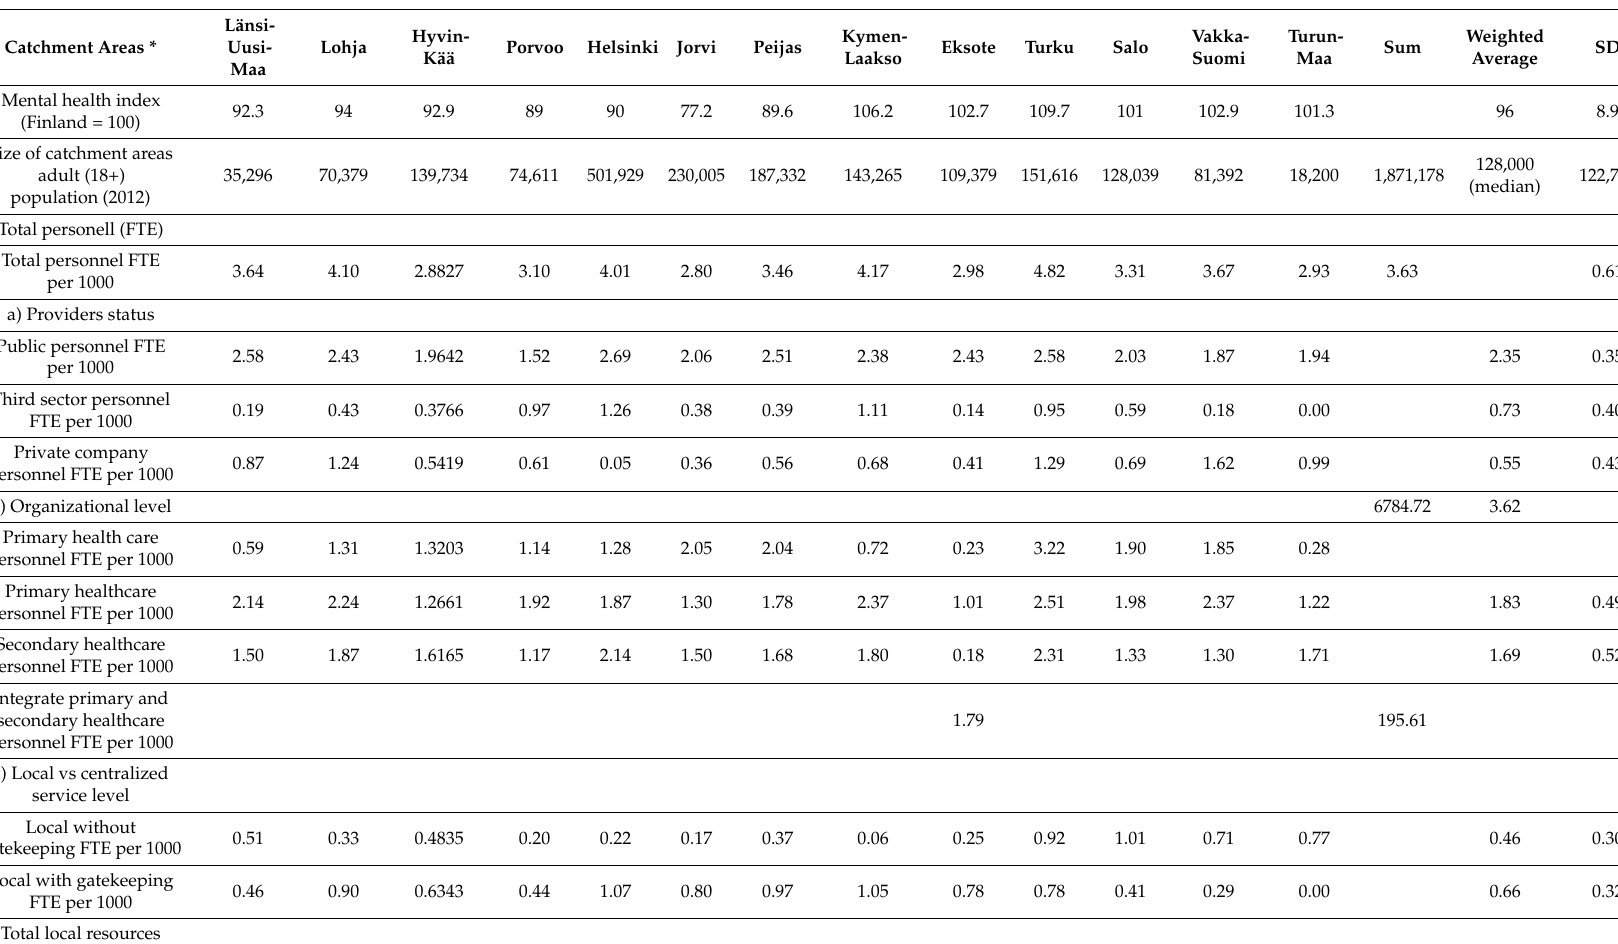
Kymen- Eksote Turku Salo Laakso